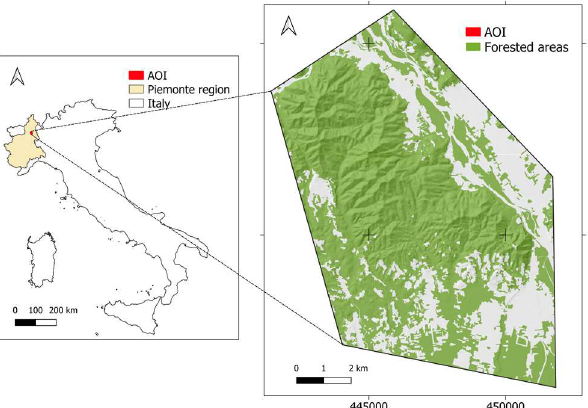
Figure 1 . AOI location. Reference frame is WGS84 UTM 32N.